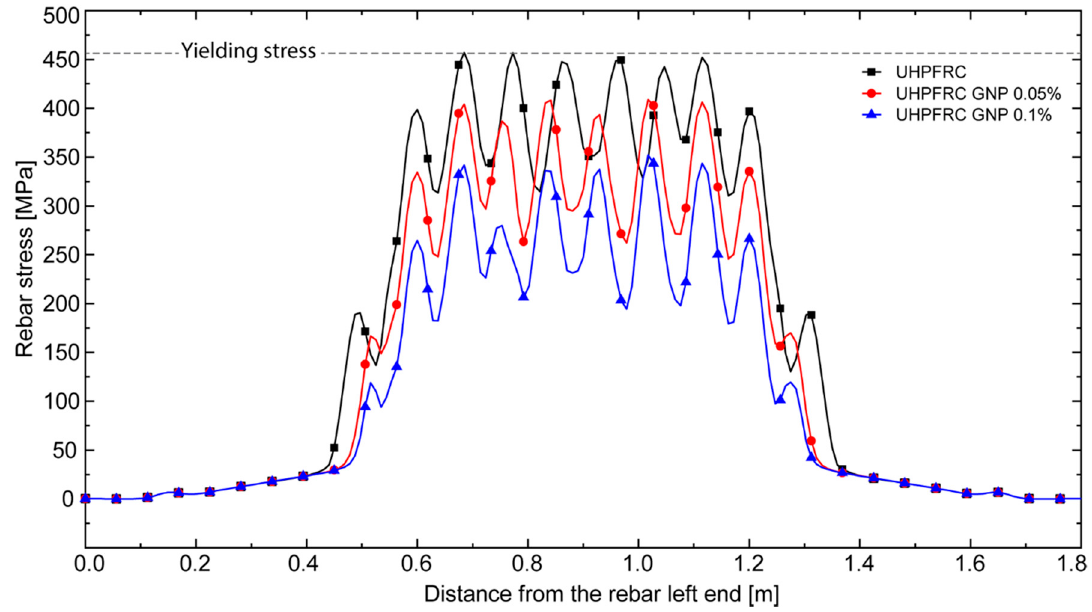
Figure 11. Axial stress distribution along the tensile longitudinal reinforcement bars of the three considered UHFRC beams with different contents of GNPs, for a load level of 65 kN.